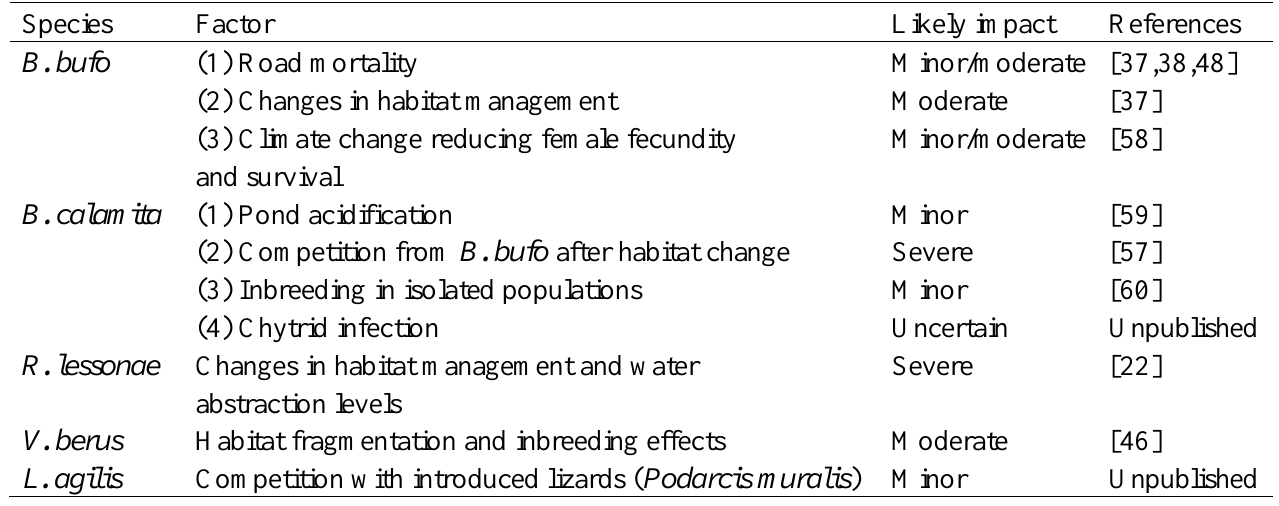
Table 9. Other factors influencing British amphibian and reptile